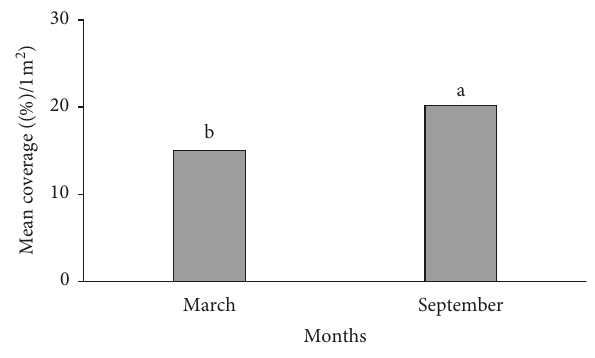
Figure 9: The differences of parthenium abundance as measured by weed coverage (%) for parthenium weed between March and September 2015 at Kuala Muda, Kedah. Dissimilar small letters on bars indicate significant